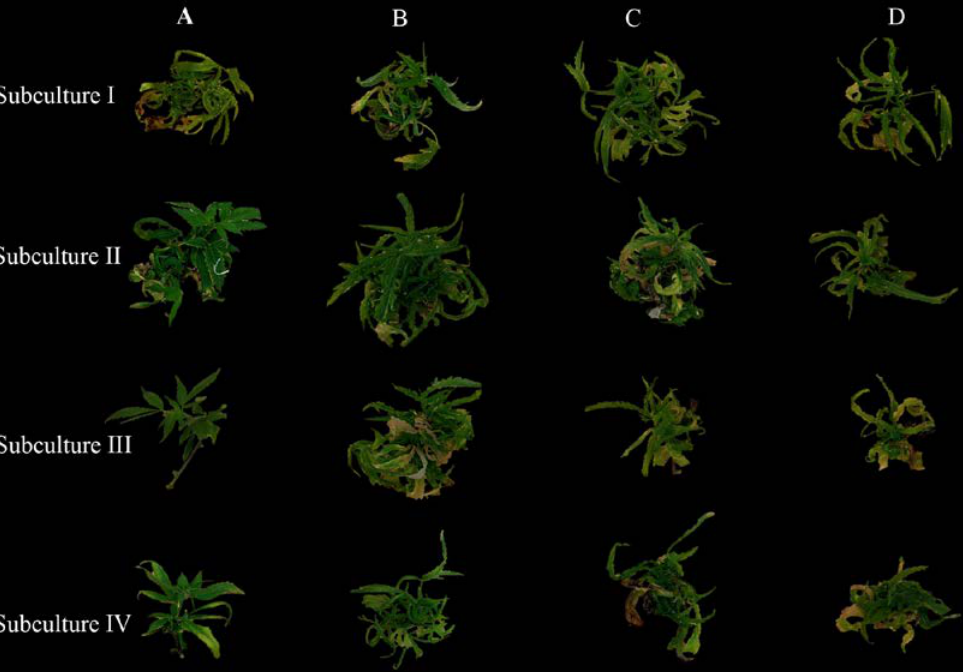
Figure 2. Effect of the source of explants and number of subcultures on in vitro multiplication of cannabis. The explants derived from the basal, near-basal, middle, and apical parts are respectively illustrated as A, B, C, and D. Table 1. Effect of the source of explants and number of subcultures on plantlets height (PH), number of nodes (NN), number of shoots (NS), and canopy surface area (CSA) during in vitro multiplication of cannabis.